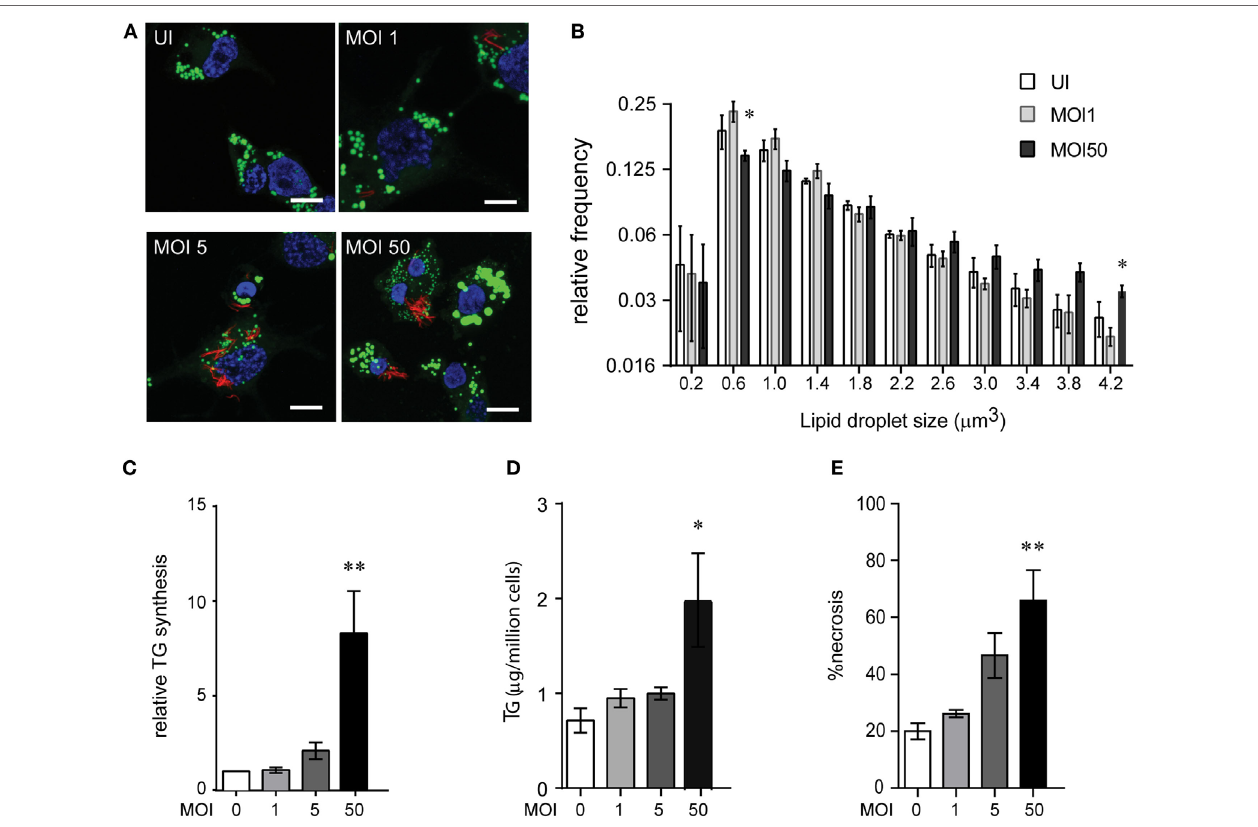
FigUre 3 | High multiplicity of infection (MOI) increases TG accumulation in human macrophages concomitant to necrosis. (a) BODIPY 493/503 (green) and DAPI (blue) stained THP1 macrophages at 24 h post infection with MOI 1. mCherry + Mycobacterium tuberculosis can be seen in red. Scale bar = 10 μ m. (B) Assessment of mean LD size estimated from five confocal z-stacks of each condition per experiment. Data are mean ± SEM from two to three independent experiments. (c) TG synthesis relative to uninfected cells, estimated in macrophages infected with indicated MOI at 24 h post infection and normalized to number of cells at the end of 24 h infection. Data are mean ± SEM from three independent experiments. (D) TG estimation in adherent cells at 24 h post infection with indicated MOI. Data are mean ± SEM from three independent experiments. (e) Quantification of cell death measured by LDH activity and represented as % of necrosis relative to detergent lysed cells. Data are mean ± SEM from three experiments. One-way ANOVA followed by Dunnett’s test derived p -values are indicated only for the significantly different groups relative to uninfected cells (** p < 0.01, and * p < 0.05). Also see Figure S2 in Supplementary